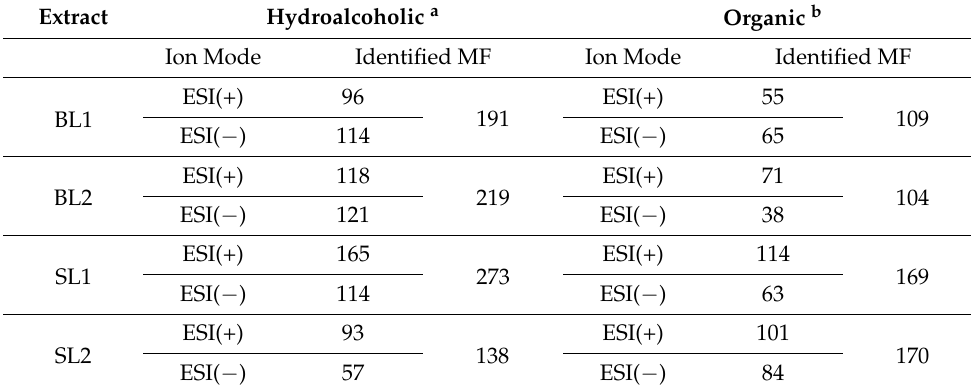
Table 3. Molecular formulas (MF) identified by electrospray ionization-mass spectrometry (ESI-MS) in Bligh-Dyer hydroalcoholic and organic extracts of Big Lifeberry (BL) and Sweet Lifeberry SL) berries harvested in periods 1 and 2.